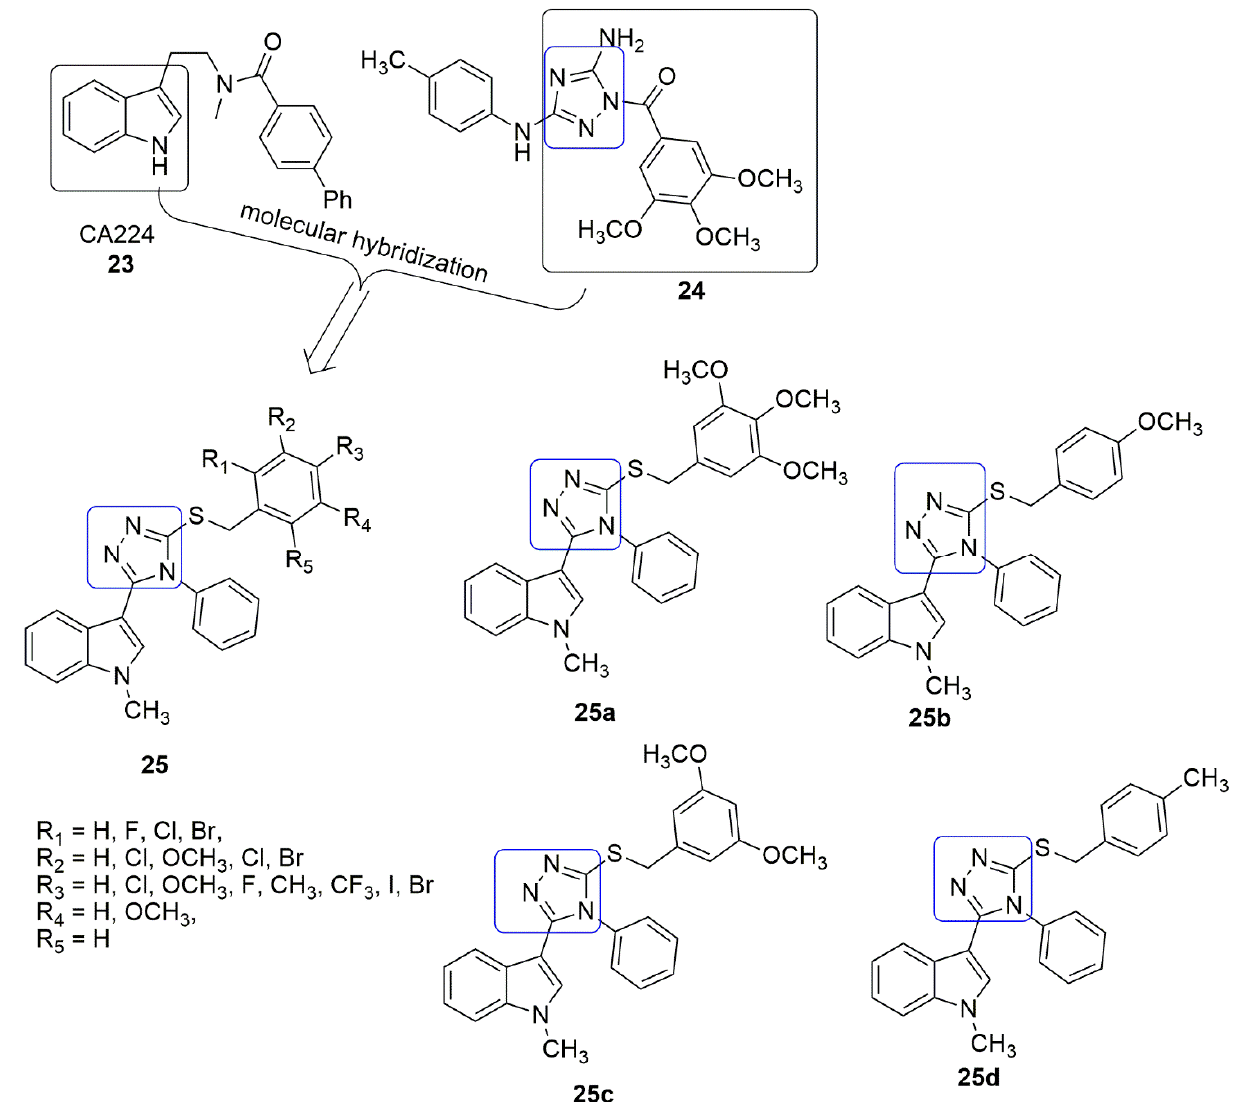
Figure 10. Chemical structures of indole-1,2,4-triazole scaffolds evaluated for anti-tubulin activity.